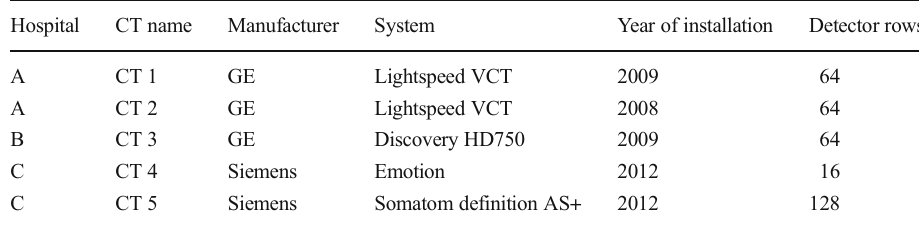
Table 1 CT systems used in the three hospitals Hospital